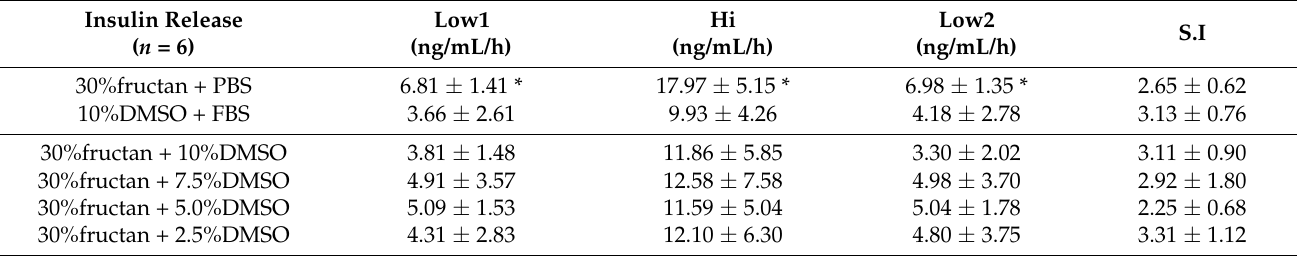
Figure 5. Synergistic effects of fructan and DMSO on islet survival rate during cryopreservation. Table 2. Study of synergistic effects of fructan and DMSO Insulin release